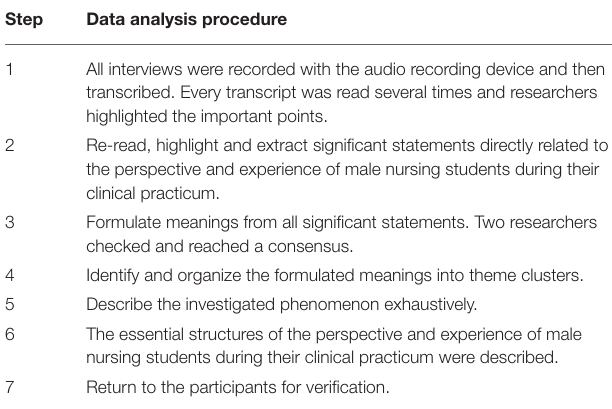
TABLE 4 | Colaizzi’s seven-step framework for qualitative data analysis.